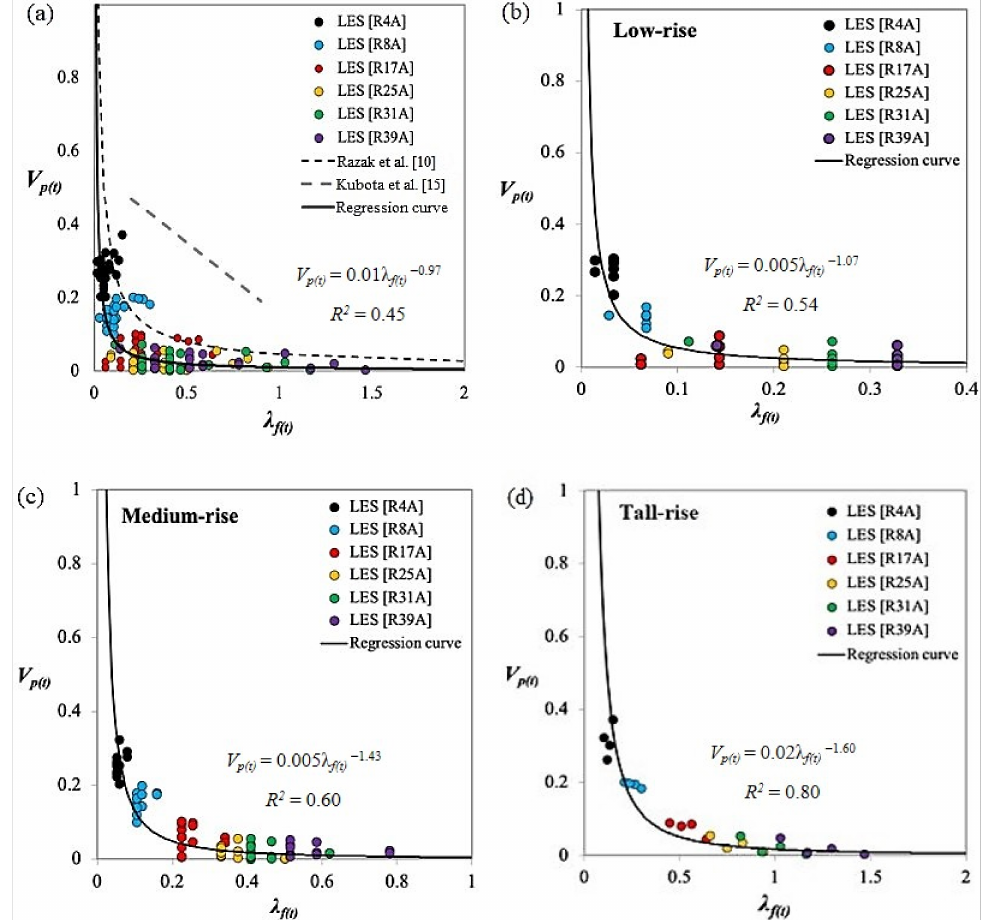
Figure 7. ( a ) Relationship between V p(t) and λ f(t) for each building of all random staggered arrays, ( b ) low-rise, ( c ) medium-rise, and ( d ) high-rise